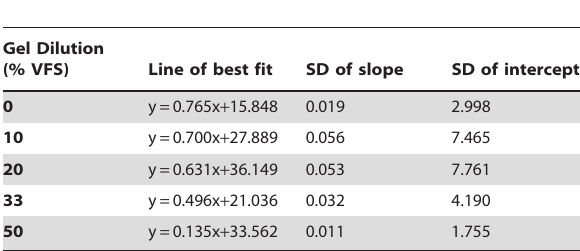
Table 2. Results from weighted least-squares regressions performed on each dilution (SD = standard